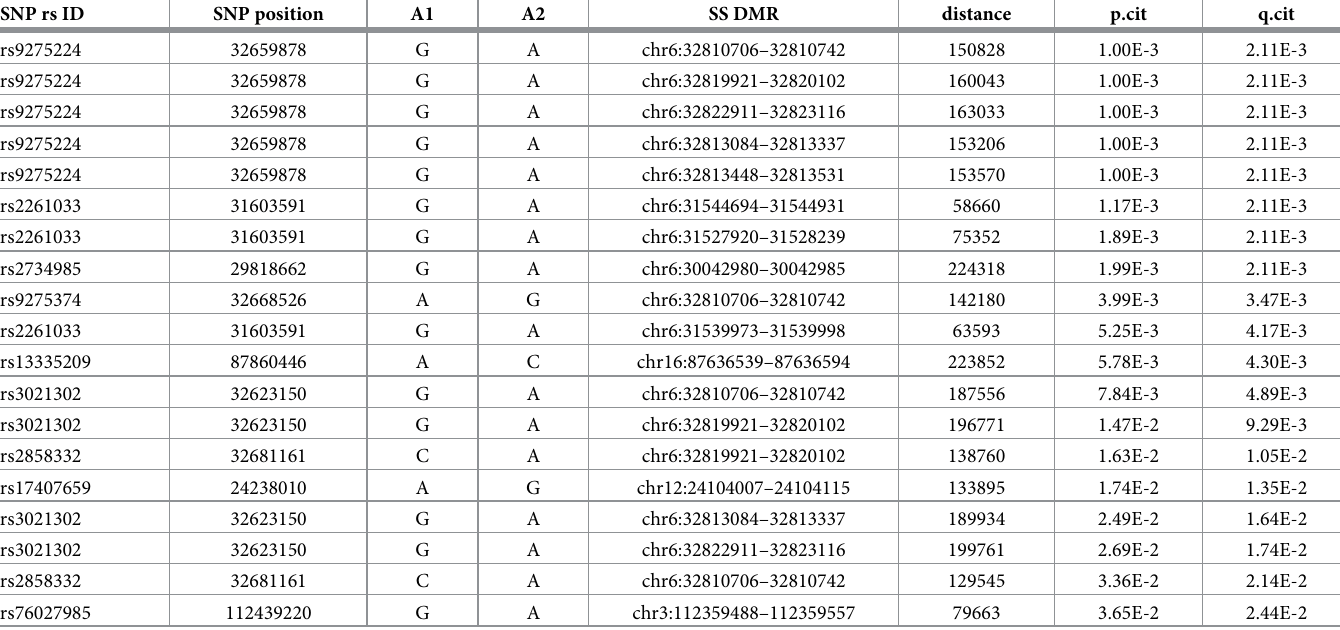
Table 4. Top causal inference test results for meQTLs of SS DMRs.